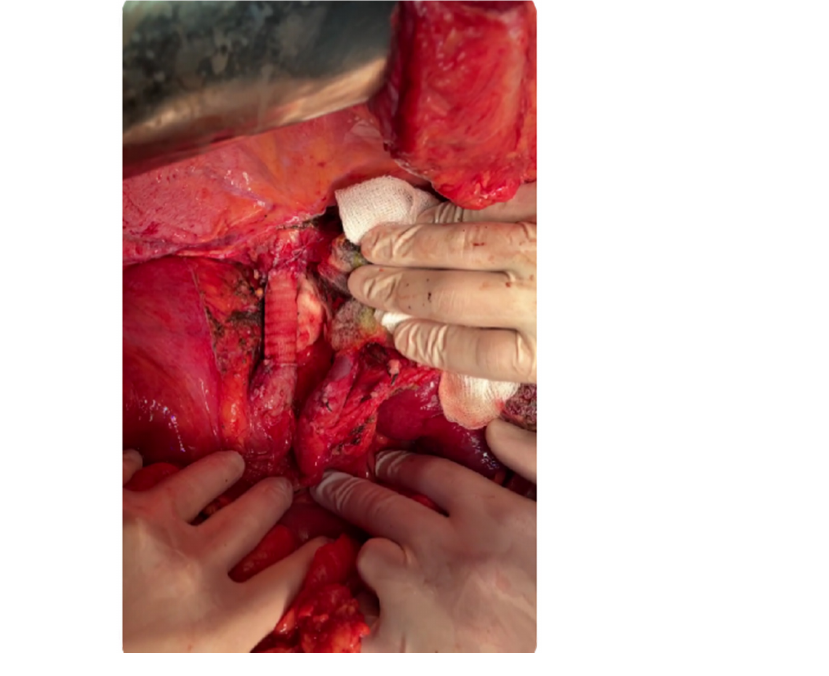
Figure 4. Intraoperative aspect revealing the presence of the reconstructed cava vein by Gore-Tex graft placement, as well as the remaining left hepatic pedicle (left portal vein, left hepatic artery, left bile duct).